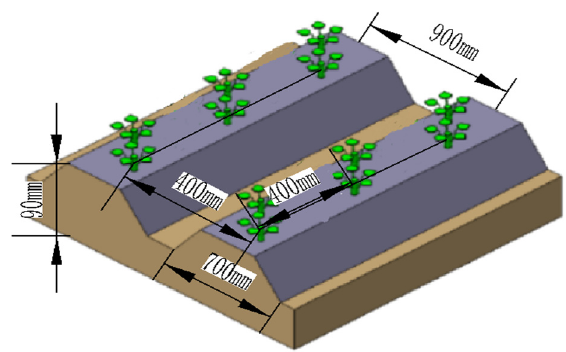
Figure 2. Ridging mode of double-row transplanting on cantaloupe film. Along with the characteristics of double-row transplanting on the cantaloupe film, the main technical parameters of the machines and tools are shown in Table 1. Table 1. Transplanting machine technical parameter table.